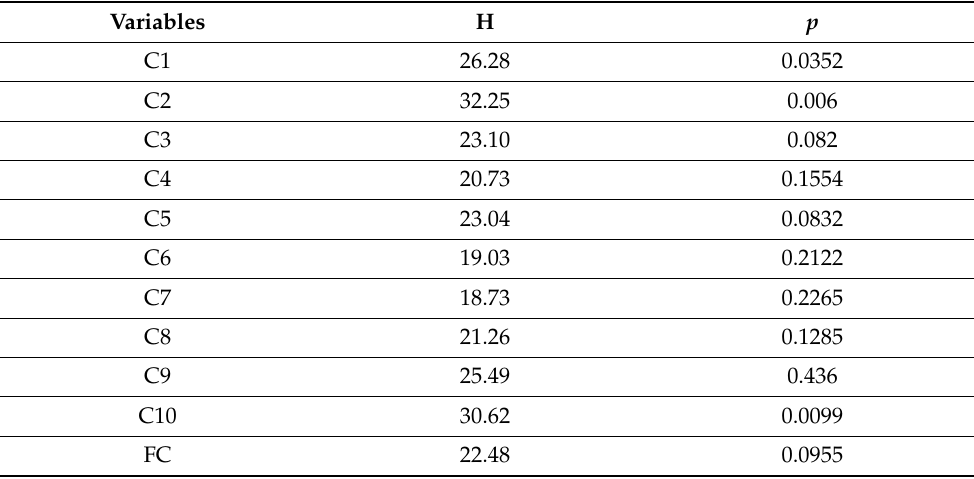
Table 4. The results of the ANOVA Kruskal-Wallis test for differences in the functioning of the creative sector between